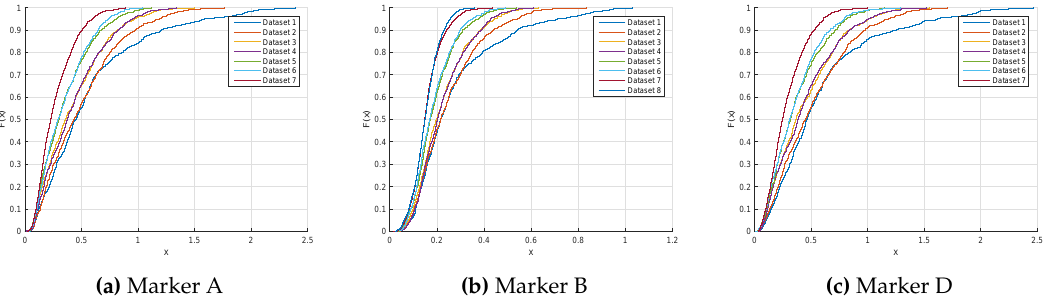
Figure 14. Position error cumulative distribution functions ( x -axis in